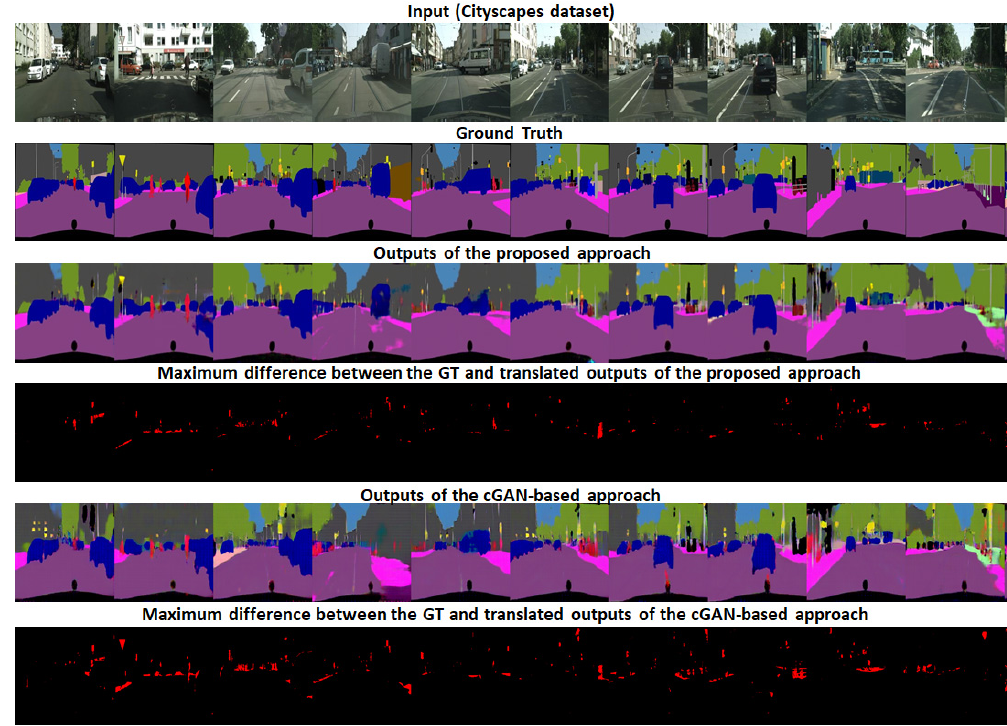
Figure 6. Comparative analysis of the proposed approach with cGAN [10] with emphasis on the high-error regions using the Cityscapes